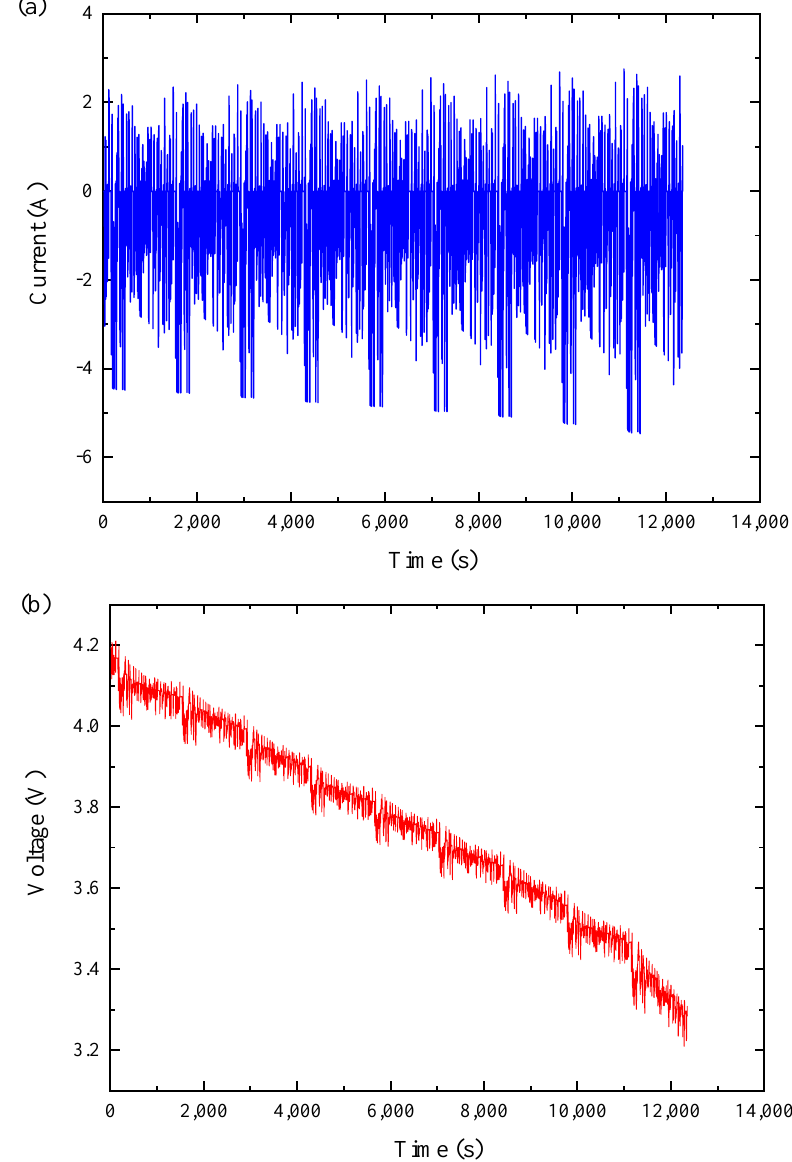
Figure 5. The profile of validation test cycles: ( a ) current profile; ( b ) voltage response.